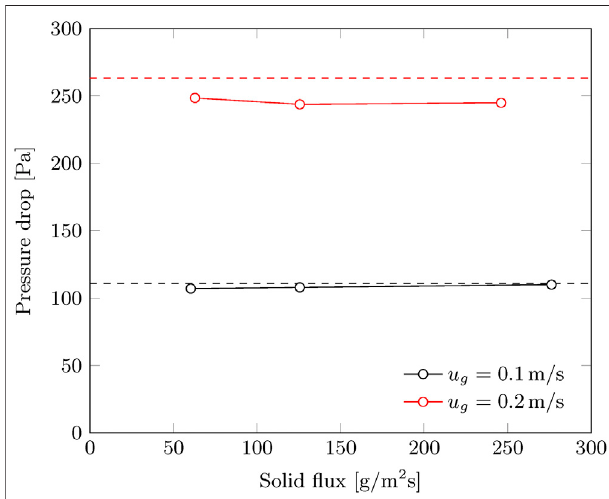
FIGURE 9 | Pressure drop over the radial fl ow moving bed contactor as function of solid fl